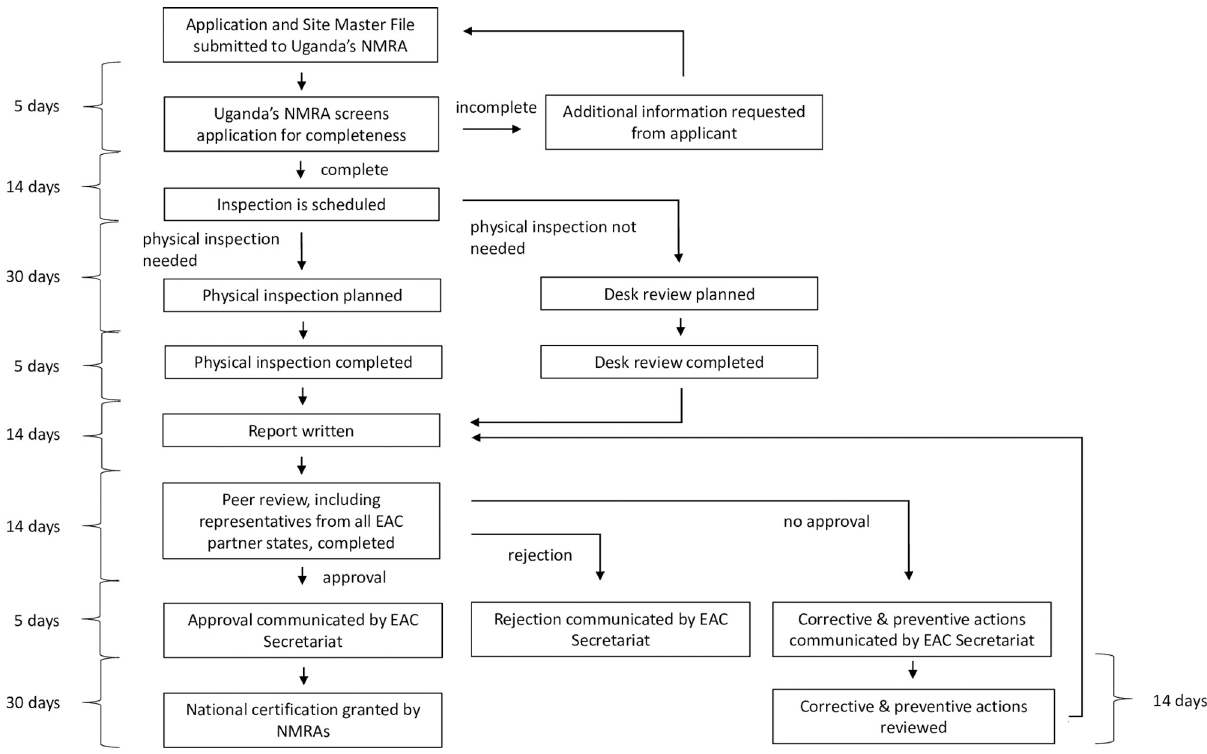
Fig 3. The joint good manufacturing process inspection pathway of the EAC’s Medicines Regulatory Harmonization initiative. EAC, East African Community; NMRA, national medicines regulatory authority.